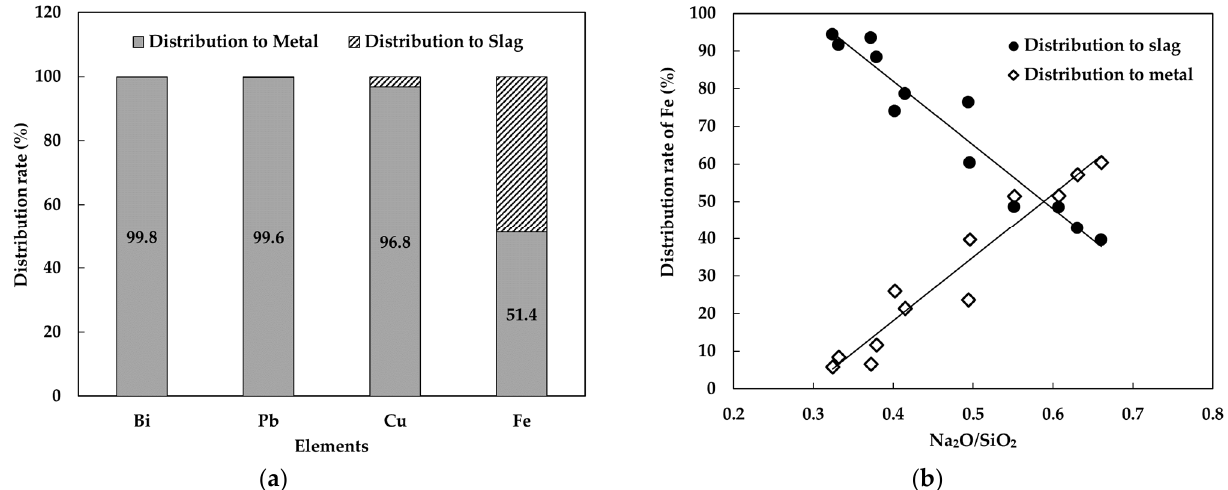
Figure 11. The distribution rate ( a ) of impurities (1200 °C, 2 h, Na 2 O/SiO 2 = 0.55); ( b ) of Fe with Na 2 O/SiO 2 ratio (1200 °C, 2 h).